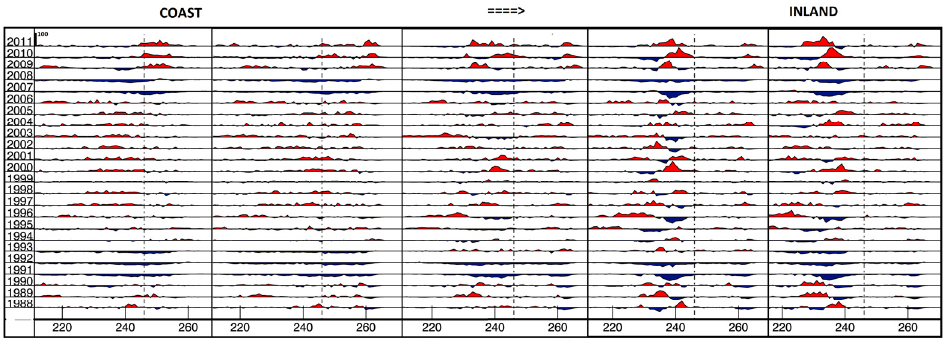
histogram anomalies (difference from the average of Figure 5. Time series of T b 1988–2011) for a coast to inland transect from Malaspina to Hubbard Glaciers (see the dark blue rectangle in Figure 3 for location).